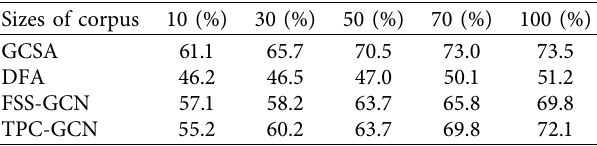
Table 5: Detection performance with different sizes of corpus (on the testing set). Sizes of corpus